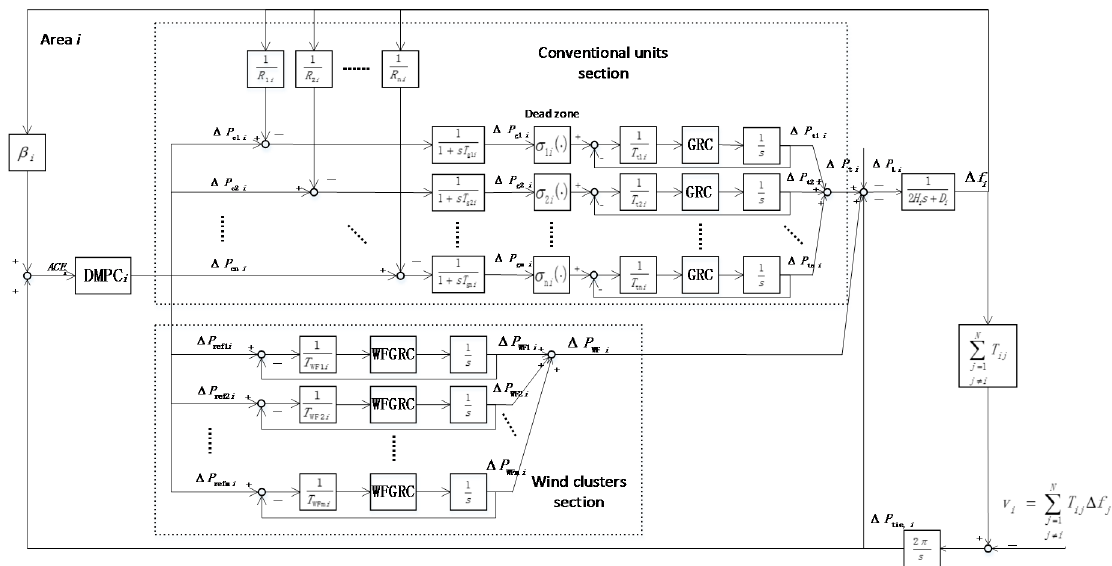
Figure 1. Frequency response model of multi-area interconnected power system. Table 1. Parameters and variables.